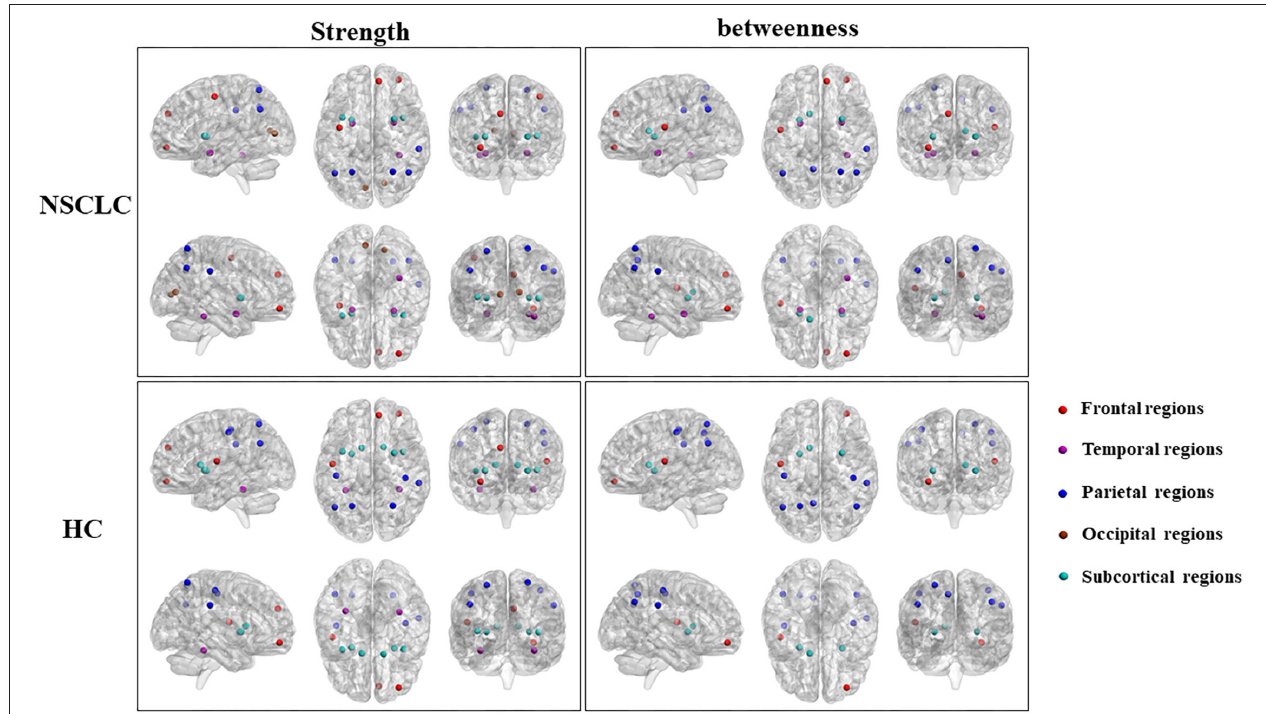
FIGURE 4 | Differences in the distribution of hub regions between NSCLC and HC. NSCLC, non-small cell lung cancer; HC, healthy control. The abbreviations of brain regions were presented in the Supplementary Material online.